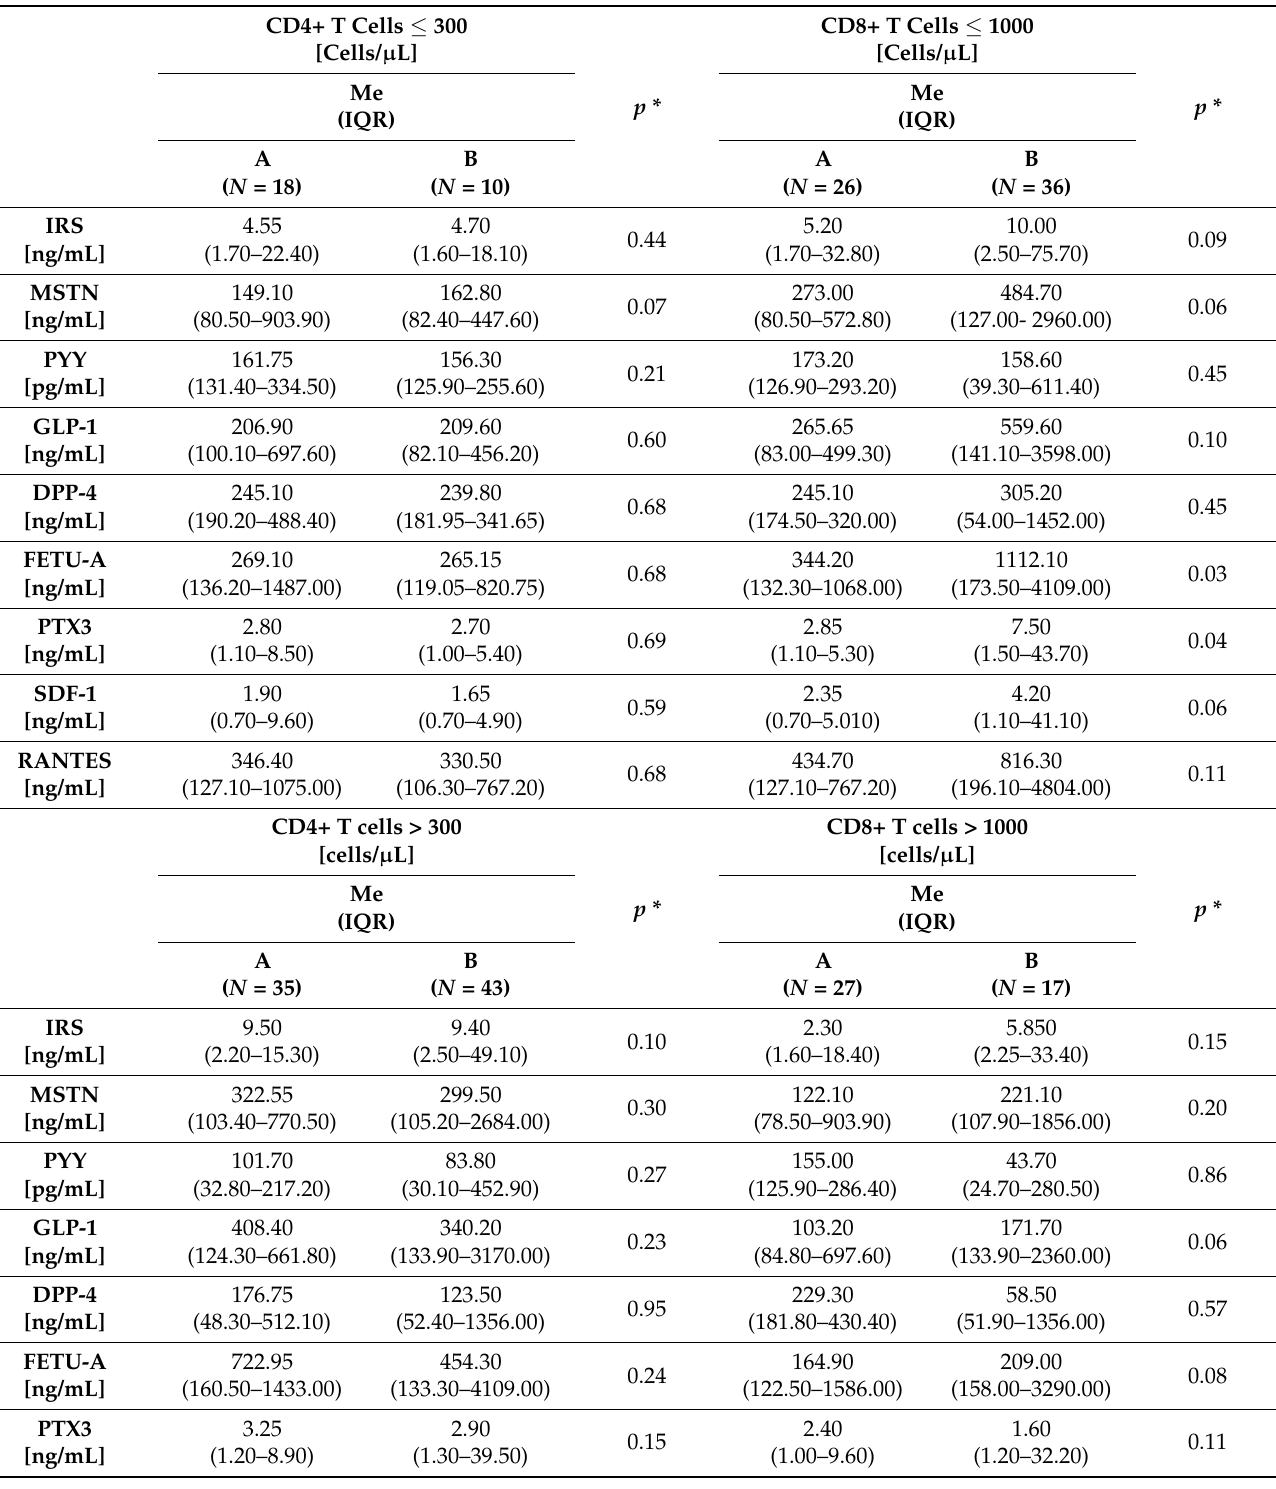
Table 4. Results of selected parameters before and after cART in HIV-infected men by CD4+ T cells count (below and above 300 cells/ µ L) and by CD8+ T cells count (below and above 1000 cells/ µ L) with statistical